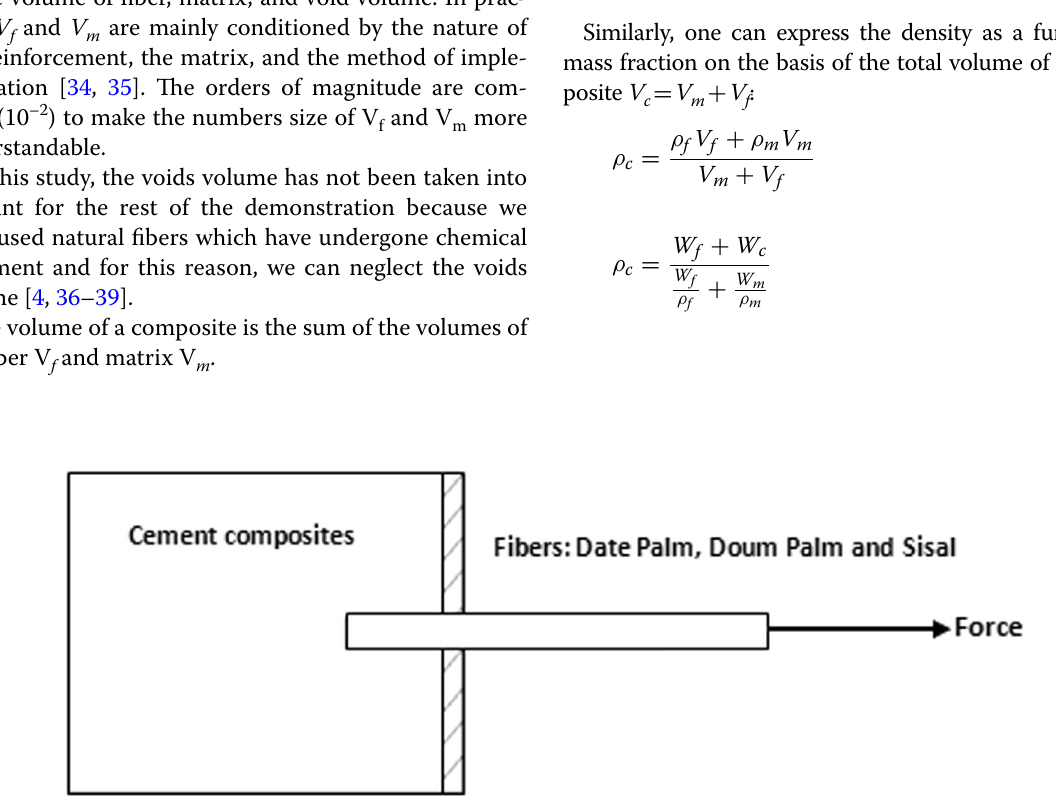
Fig. 1 Single fibers pull-out test [32,